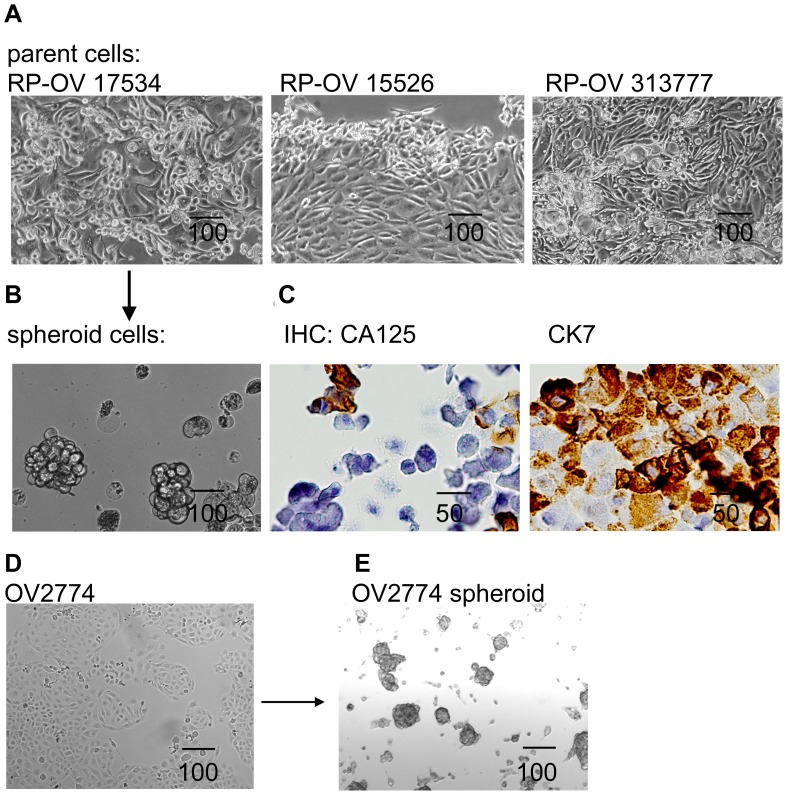
Spheroid cells were generated from primary and established EOC cells.(A) Three primary cell lines generated from EOC patients show epithelial cells morphology. (B) One of primary EOC cell line generated 3-D independent, self-renewing spheroid cells under stem-cell selection media. (C) Primary cell lines express ovarian carcinoma marker CA-125 and epithelial marker CK-7, as shown by IHC for RP-OV17534. (D) EOC cell line OV2774 is able to generate OV2774 spheroid cells (E). All scale bar unit in this figure and following figures are in µm.